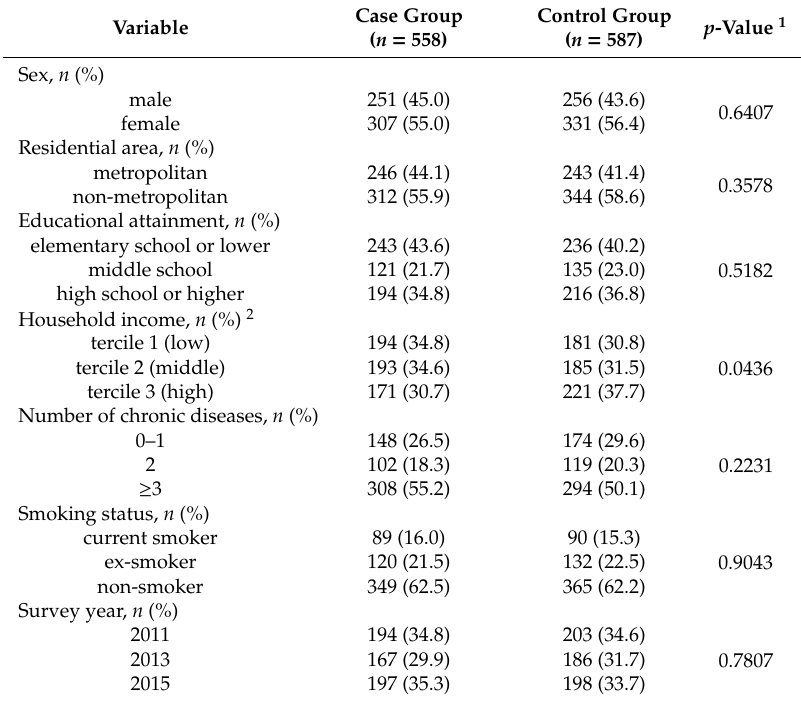
Table 1. Participants’ sociodemographic characteristics by